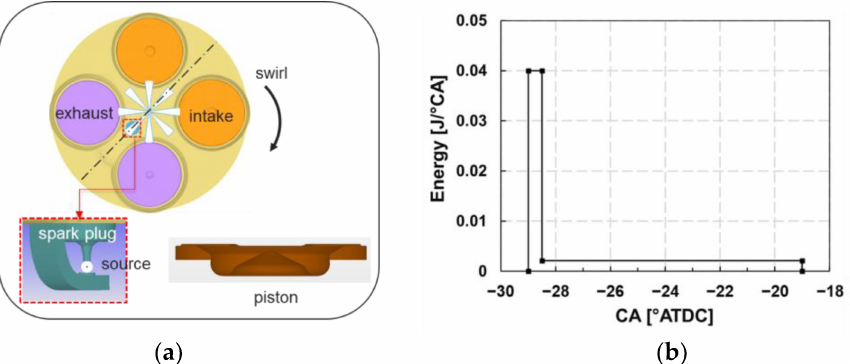
Figure 1. ( a ) Schematic of cylinder head, injector, spark plug, and piston; ( b ) a two-stage energy